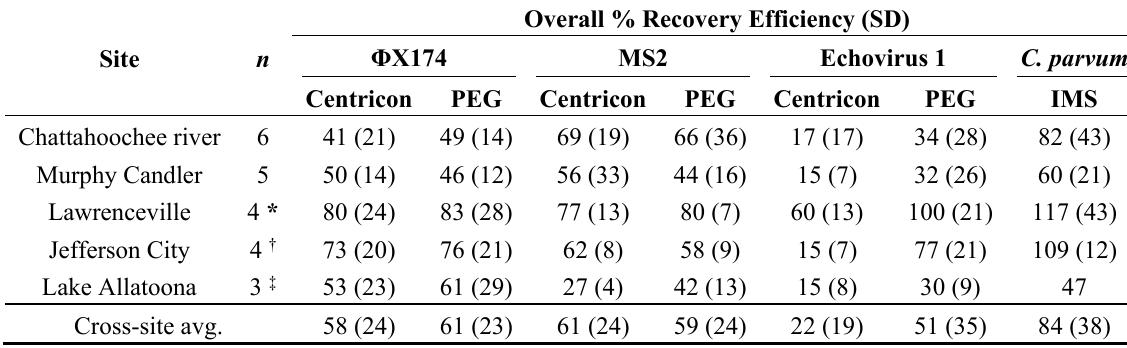
Table A1. Overall recovery efficiencies for microbes undergoing secondary